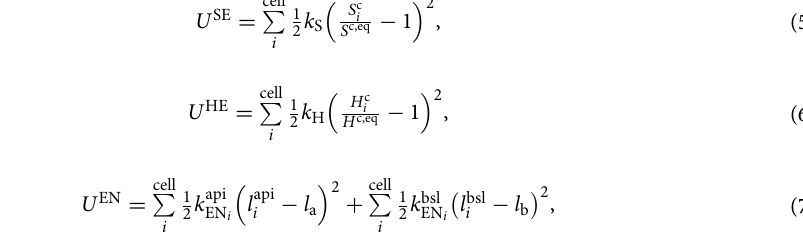
api l bsl i and i represent the out-of-plane displacement of the api k bsl EN i indicate EN i and